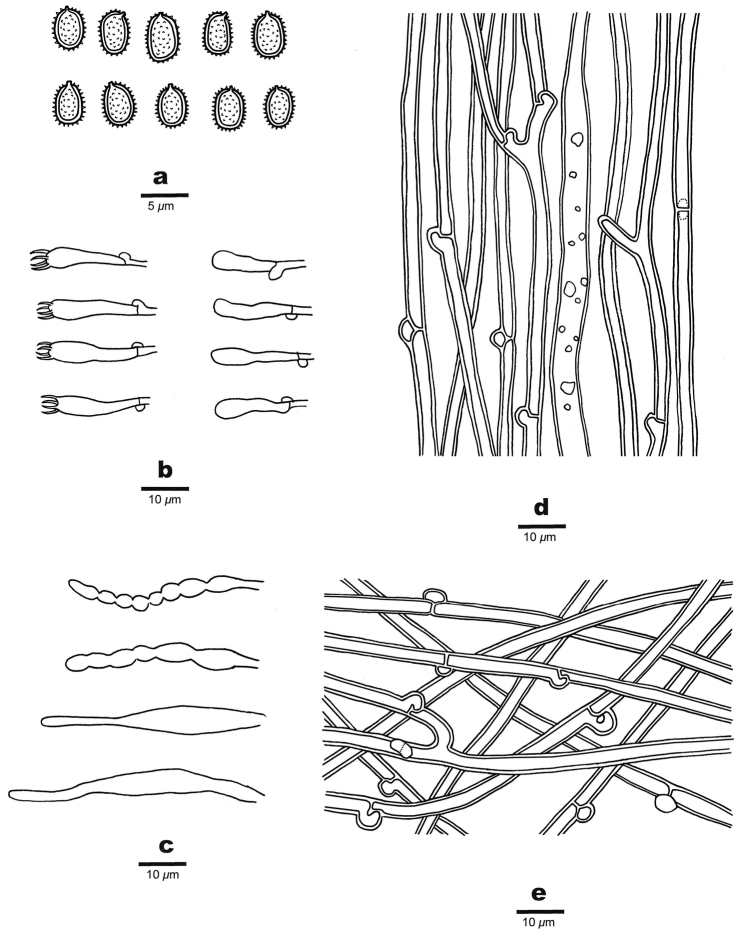
Microscopic structures of Dentipellistasmanica (holotype). a Basidiospores b Basidia and basidioles c Gloeocystidia and Cystidioles d Hyphae from trama e Hyphae from subiculum.